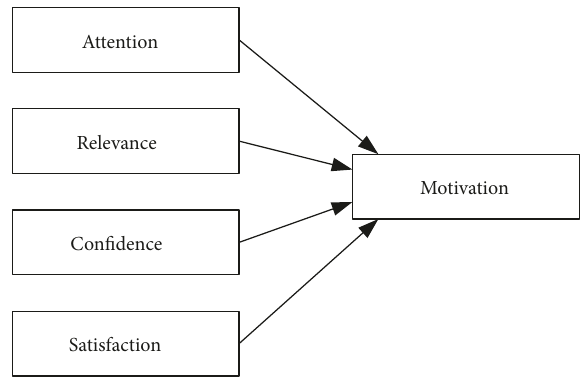
Figure 2: Keller’s ARCS model of motivational design